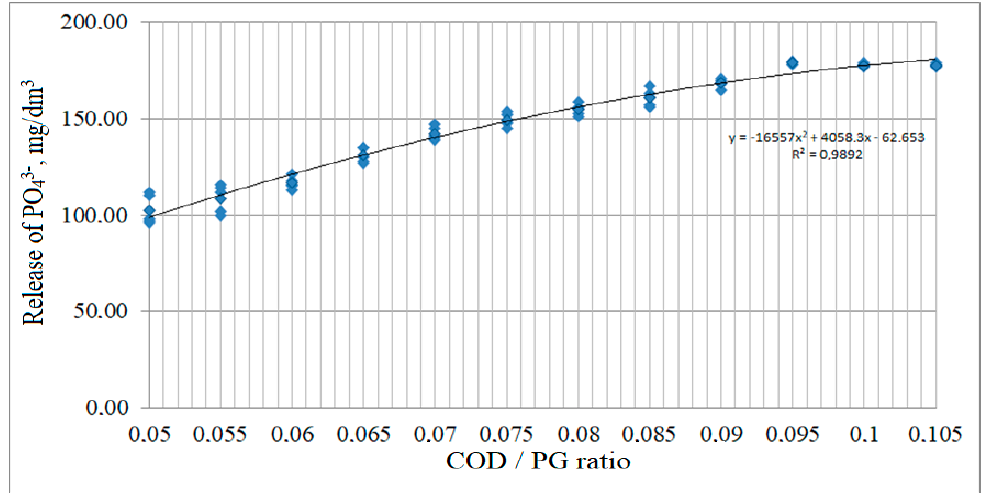
Figure 13. Influence of COD/PG ratio on phosphate release.